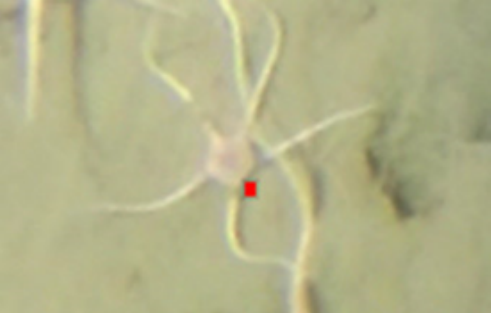
Figure 7. Example of false positive prediction which is still useful for